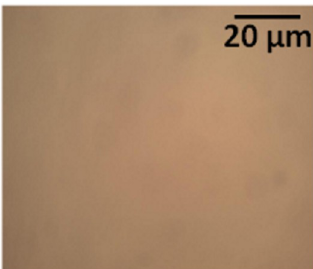
Figure 8. Optical image of slot-die coated F8:F8BT on a previously slot-die coated PEDOT:PSS layer.